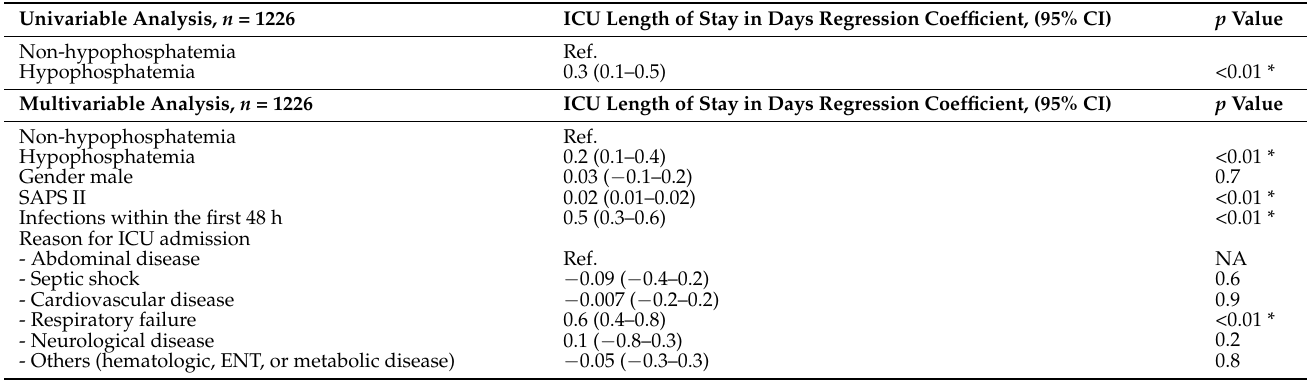
Table A4. Hypophosphatemia and ICU length of